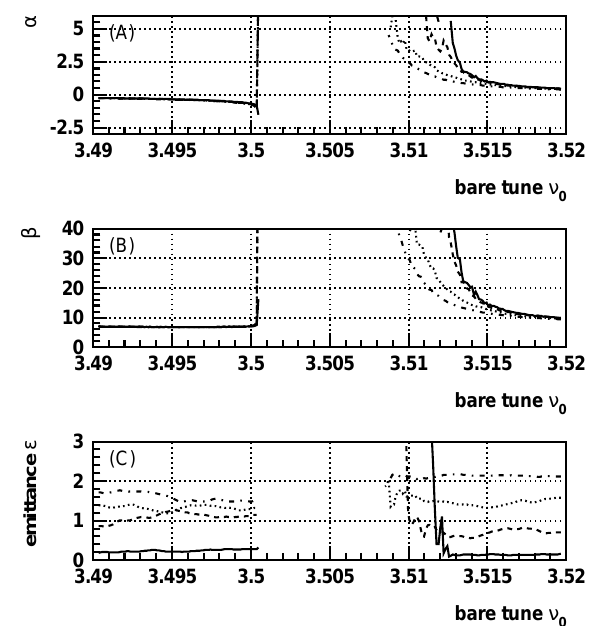
FIG. 13. Twiss parameters and emittances of four macro- particles, which were calculated by fitting the 500 turn phase trajectory to g y 2 1 2 a yy 0 1 b y 0 2 (cid:1) e . The solid line corre- sponds to a macroparticle with the lowest initial